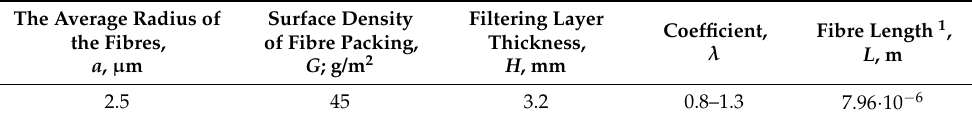
Table 1. Parameters of the filtering polypropylene material